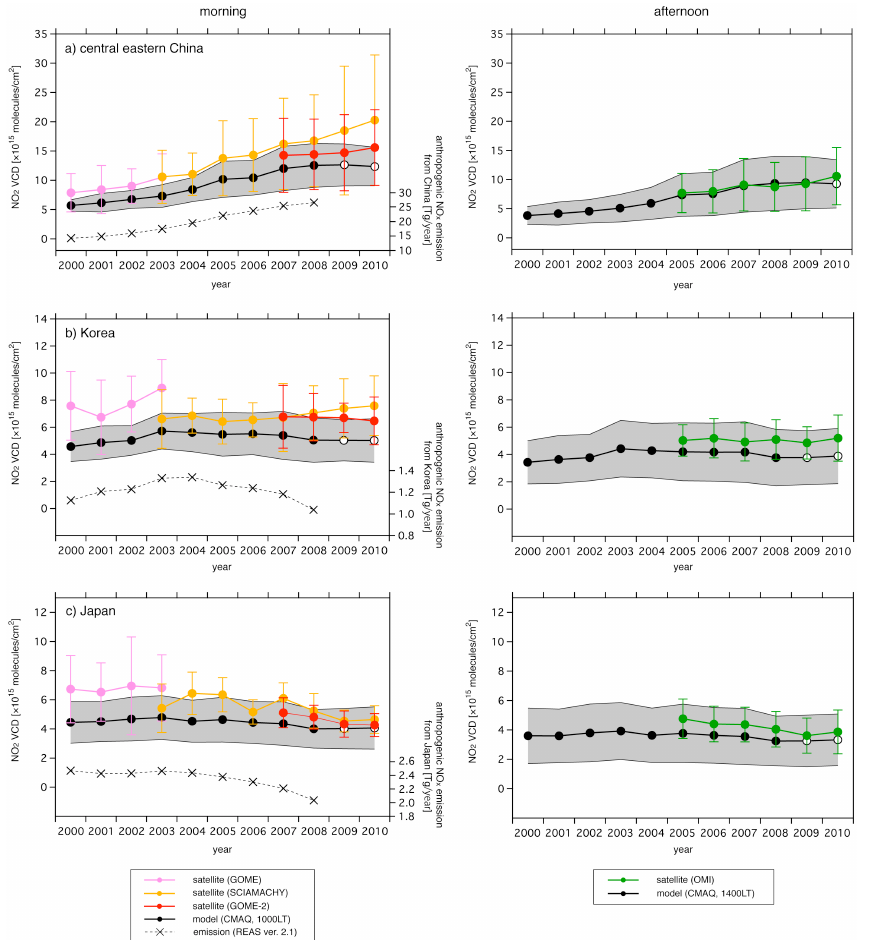
Fig. 5. Trend in annual mean tropospheric NO 2 VCD during the period 2000–2010 from multisatellite observations (GOME, SCIAMACHY, GOME-2, and OMI) and model results (open circles denote sensitivity simulations with anthropogenic emissions fixed at 2008 values) above (a) central eastern China (CEC), (b) Korea, and (c) Japan, in the (left) morning and (right) afternoon. Bars and shaded areas indicate one standard deviation.